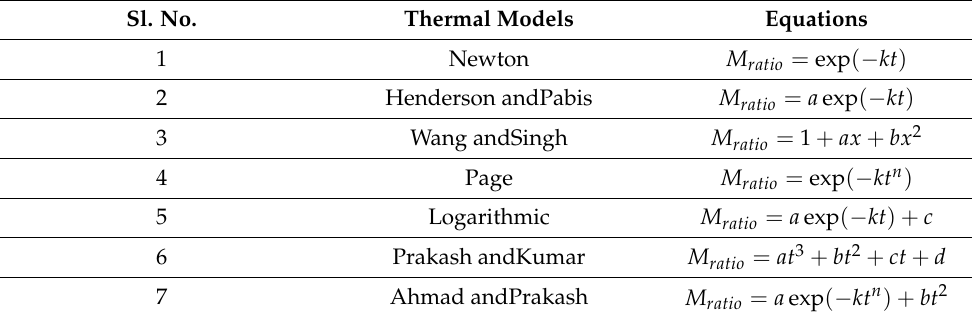
Table 1 lists the equations for several frequently used thin-layer drying models. Table 1. Thermal Models [67]. Sl.